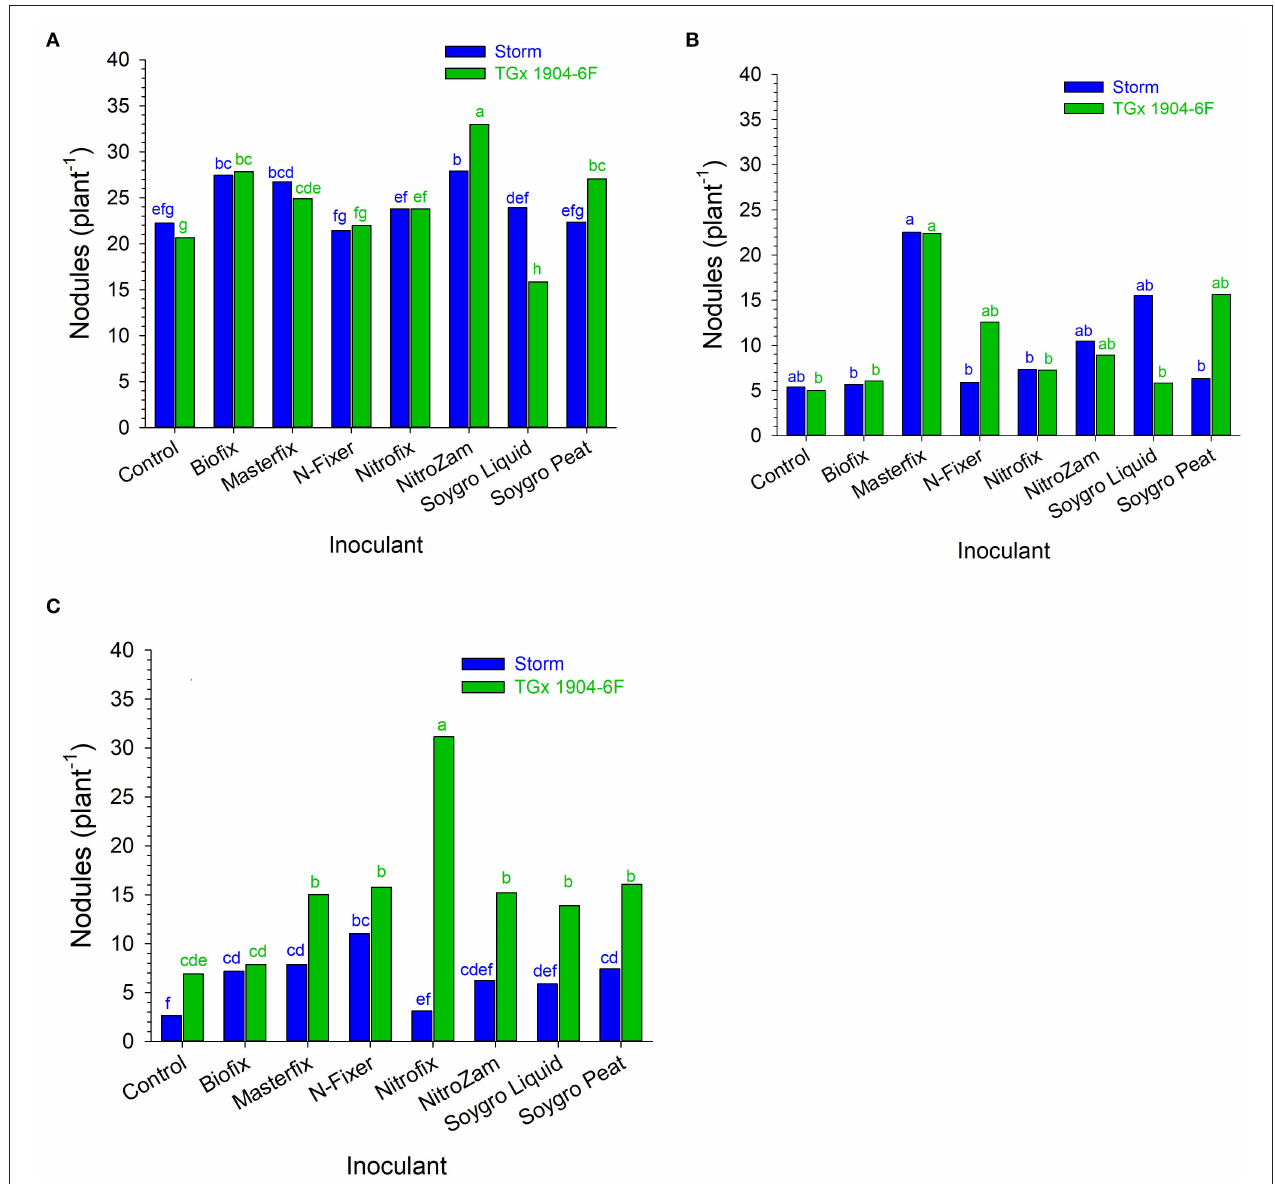
FIGURE 1 | Nodule population (plant − 1 ) following inoculation of soybean at (A) Nampula 2016, (B) Ruace 2016, and (C) Ruace 2017. Small letters on the bars indicate no significance while different letters show significant differences in means.